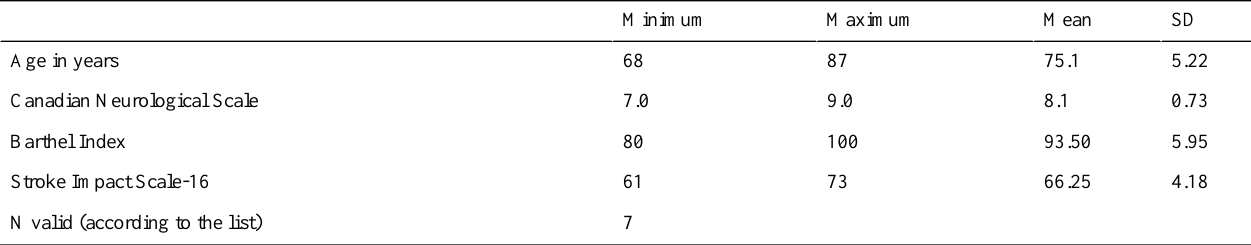
Table 1. Descriptive values of participants .